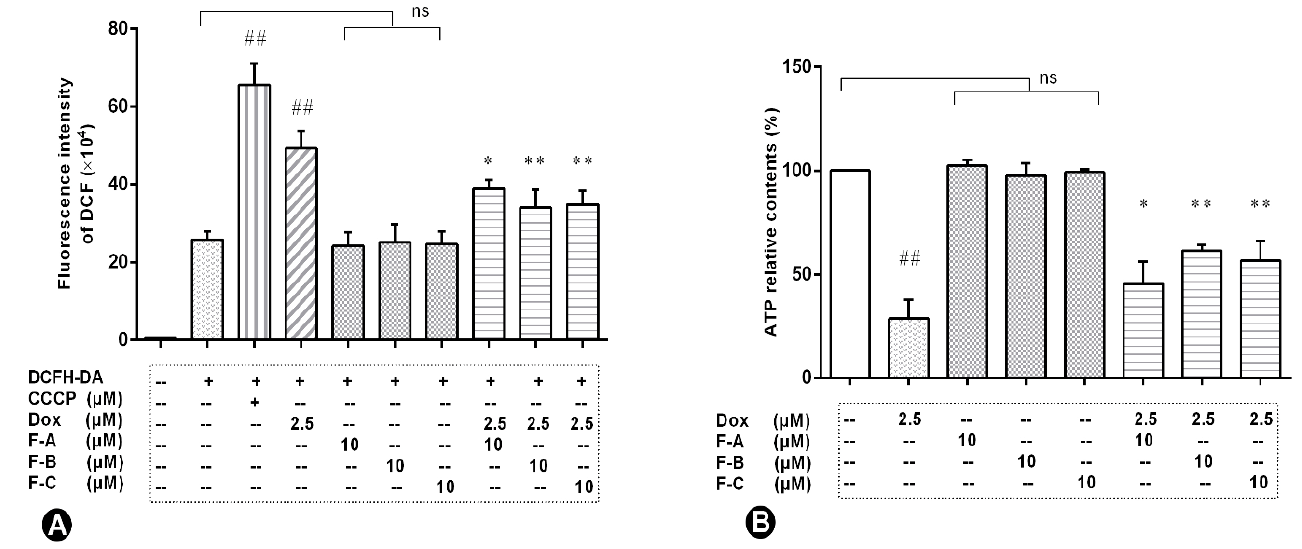
Figure 5. The effects of three flavonoids on intracellular ROS level ( A ) and ATP content ( B ) under Dox treatment in H9c2 cells. Cells were pretreated with same concentrations of F-A, F-B, and F-C (10 µ M) for 1 h, then exposed to Dox for 24 h. CCCP (carbonyl cyanide 3-chlorophenylhydrazone) as a negative contrast group. ( A ) The DCF fluorescence intensity in Dox group significantly increased compared to the NC group ( p < 0.01). There was no marked change of DCF fluorescence intensity in the F-A, F-B, and F-C group without Dox. But F-A, F-B, and F-C can significantly inhibit the Dox-induced elevation of ROS level in comparison to the Dox model group ( p < 0.01). ( B ) H9c2 cells treated with 2.5 µ M Dox rapidly reduced the content of ATP. Compared to the NC group, F-A, F-B, and F-C with the absence of Dox has no significant decrease ( p > 0.05) the content of ATP. The content of ATP compared to the Dox group was significantly increased by the administration of F-A, F-B, and F-C in the presence of 2.5 µ M Dox. Results are mean ± SEM from three independent experiments. ## p < 0.01 vs. control, * p < 0.05, ** p < 0.01 vs. Dox group. ns, not